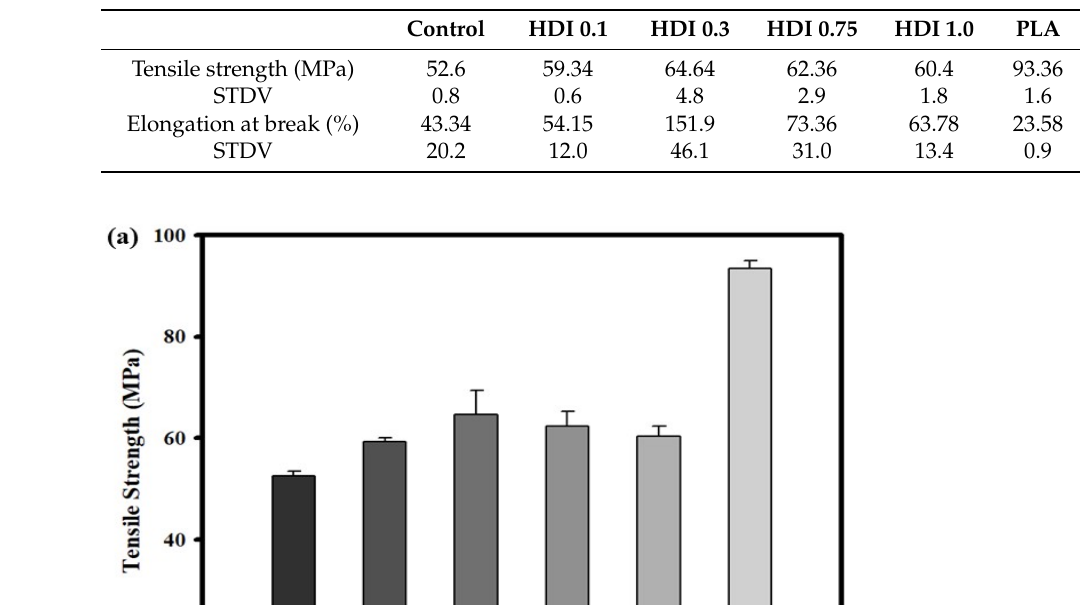
Table 3. Tensile strength and elongation at break PLA/PBSeT based blends with various HDI contents.